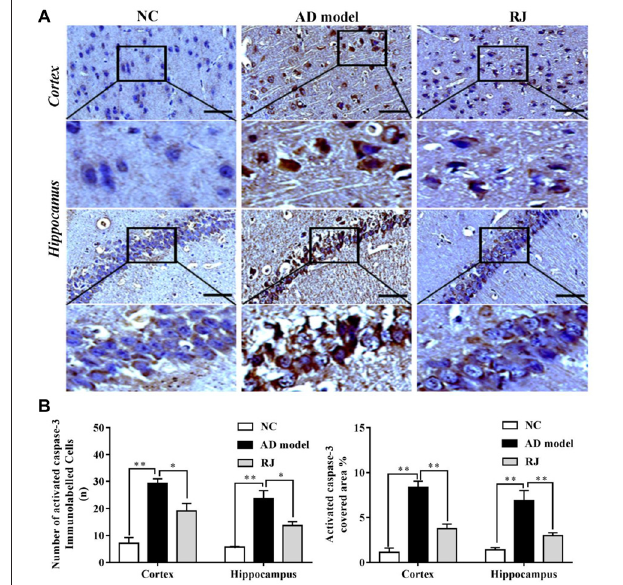
FIGURE 5 | RJ reduced activated caspase-3 expression levels in the brain of AD rabbits. (A) Representative activated caspase-3 staining sections in the brain of the AD model, RJ and NC group. Scale bar = 50 µ m. Black squares indicate images with higher-magnification. (B) The number of activated caspase-3 immunolabeled cells per view (40 × ) and the covered area of activated caspase-3 staining in the frontal cortex and the hippocampus of the three groups, n = 6 rabbits per group. Data are presented as mean ± SEM. ANOVA with post hoc Tukey’s test was used. ∗ P < 0.05, ∗∗ P < 0.01 vs. the AD model